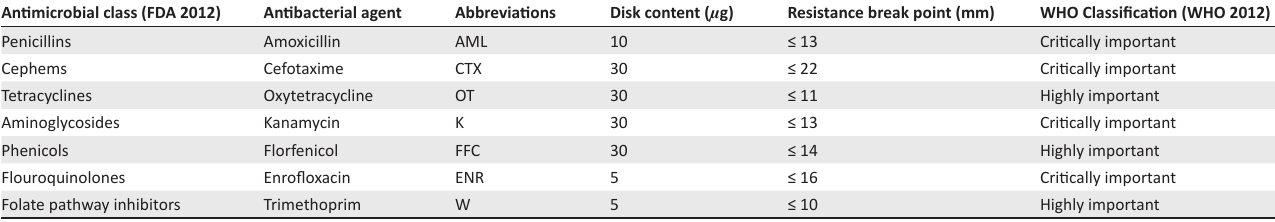
TABLE 1: Disk contents of antimicrobial and resistance break points used for disk diffusion testing of the Escherichia coli isolates ( n = 241). Antimicrobial class (FDA